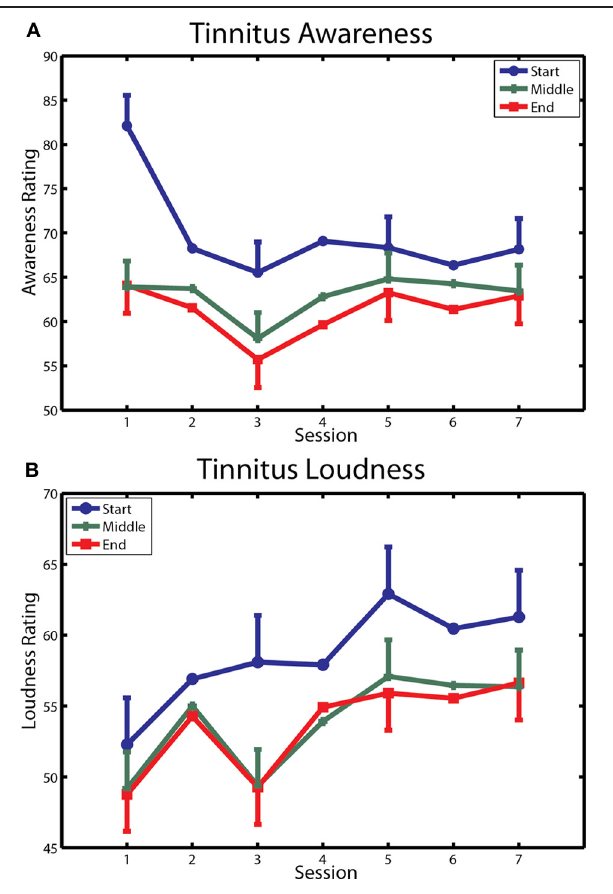
FIGURE 6 | Changes in tinnitus awareness and loudness over training. (A) Ratings of tinnitus awareness are shown for each within-session measurement over the seven sessions of training. (B) Ratings of tinnitus loudness are similarly depicted. Bars denote 1 within-subject standard